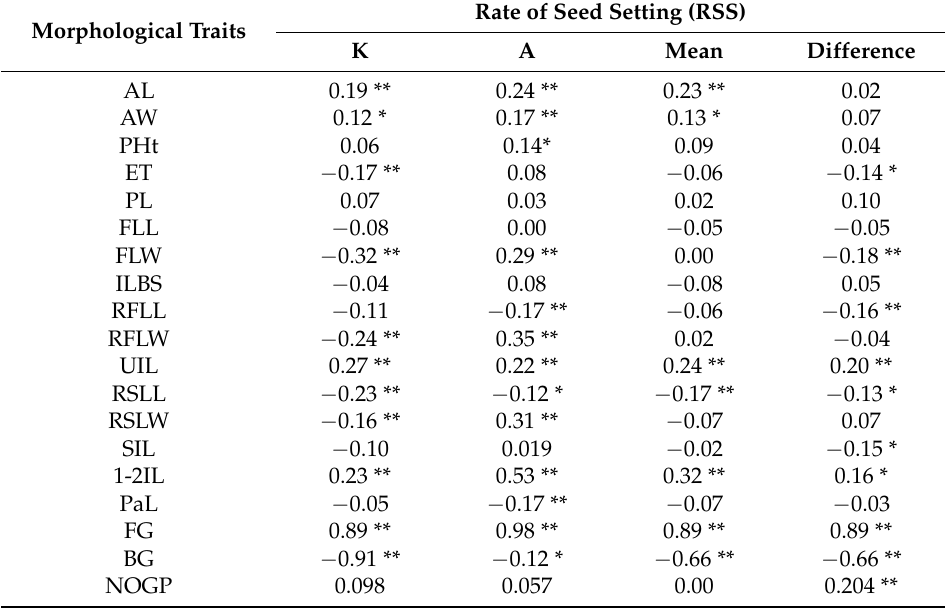
Table 2. Correlation between morphological attributes including, Anther Length (AL), Anther Width (AW), Plant Height (PHt), Effective Tillering (ET), Peduncle Length (PL), Flag Leaf Length (FLL), Flag Leaf Width (FLW), Internode Length Below Spike (ILBS), Reciprocal First Leaf Length (RFLL), Reciprocal First Leaf Width (RFLW), Uppermost Internode Length (UIL), Reciprocal Secondary Leaf Length (RSLL), Reciprocal Secondary Leaf Width (RSLW), Second Internode Length (SIL), 1st and 2nd Internode Length (1-2IL), Panicle Length (PaL), Full Grains (FG), Blighted Grains (BG), and Number of Grain Per Panicle (NOGP), with cold stress tolerance indicator, rate of seed setting (RSS), of NILs population grown at Kunming (K), and Aziying